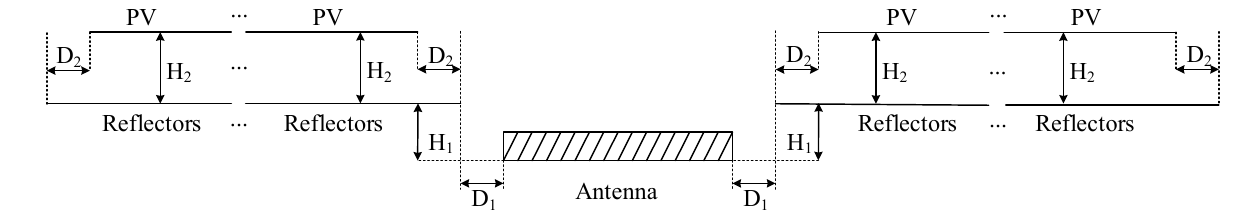
Figure 14. Configuration of the boundary dimensions.